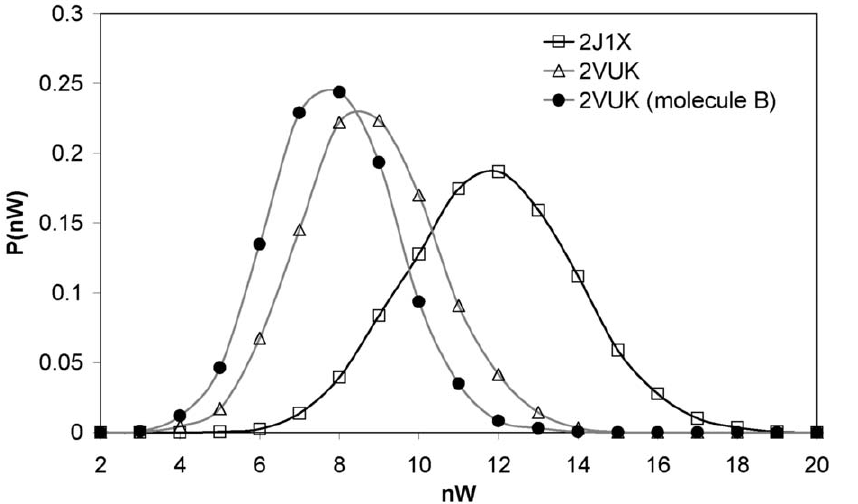
Figure 9. Distribution of the number of water molecules within the desolvation domain of the HB CYS 220– THR 155. 2J1X ( m =11.819 and s =2.111), 2VUK ( m =8.743 and s =1.720) and CYS 220– THR 155 in the second modification of Phikan083 (molecule B, m =7.847 and s